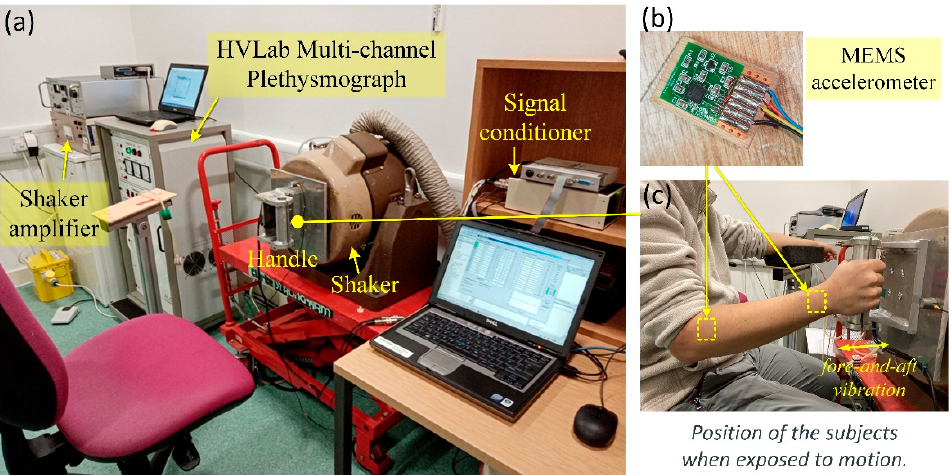
Figure 1. ( a ) The experimental set-up. ( b ) The tri-axial accelerometers used to measure the vibration transmitted to the subject. ( c ) The close-up shows the posture and position of the subject when exposed to the motion by grasping the instrumented handle. Two accelerometers were attached to the subject’s wrist and elbow, respectively, fastened by micropore tape.